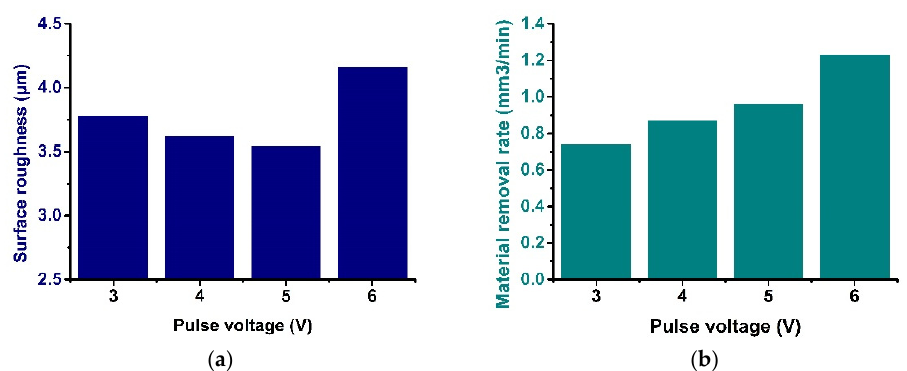
Figure 14. Roughness and material removal rate results of different specimens under different voltage: ( a ) roughness results; ( b ) material removal rate results.